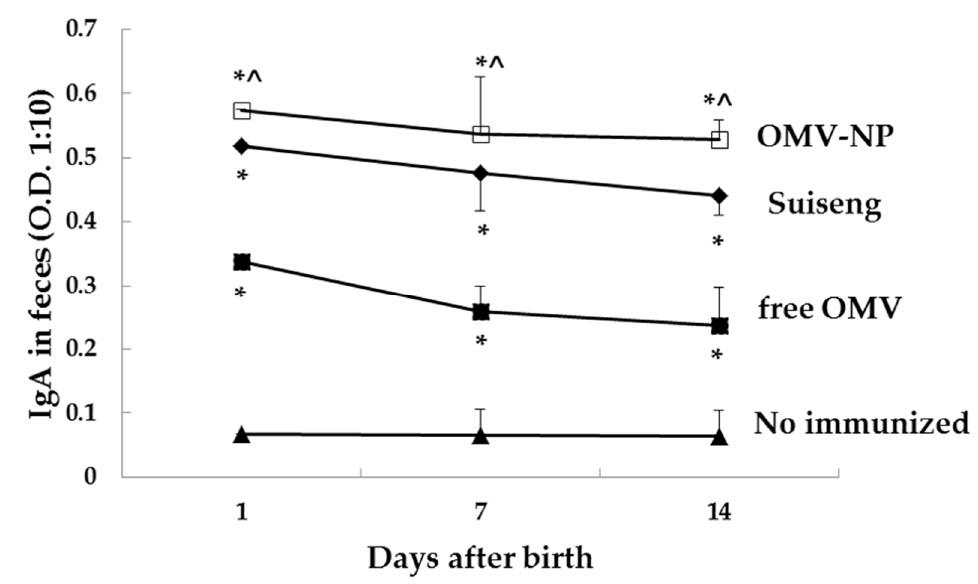
Figure 7. Antibody immune response in BALB/c mice pups from mothers immunized with OMV encapsulated into nanoparticles. Two-week-pregnant BALB/c mice were immunized orally with a single dose of OMV (0.2 mg) either free or encapsulated into nanoparticles (OMV-NP) or intraperitoneally with the commercial vaccines (Suiseng ® , Lab. Hipra). At days 1, 7 and 14 after birth, IgA was determined in fecal samples (1:10 in PBS). The results are shown as the mean levels for triplicates ± SD (* p < 0.05 for immunized mice vs. control; ^ p < 0.05 OMV-NP vs. free OMV).